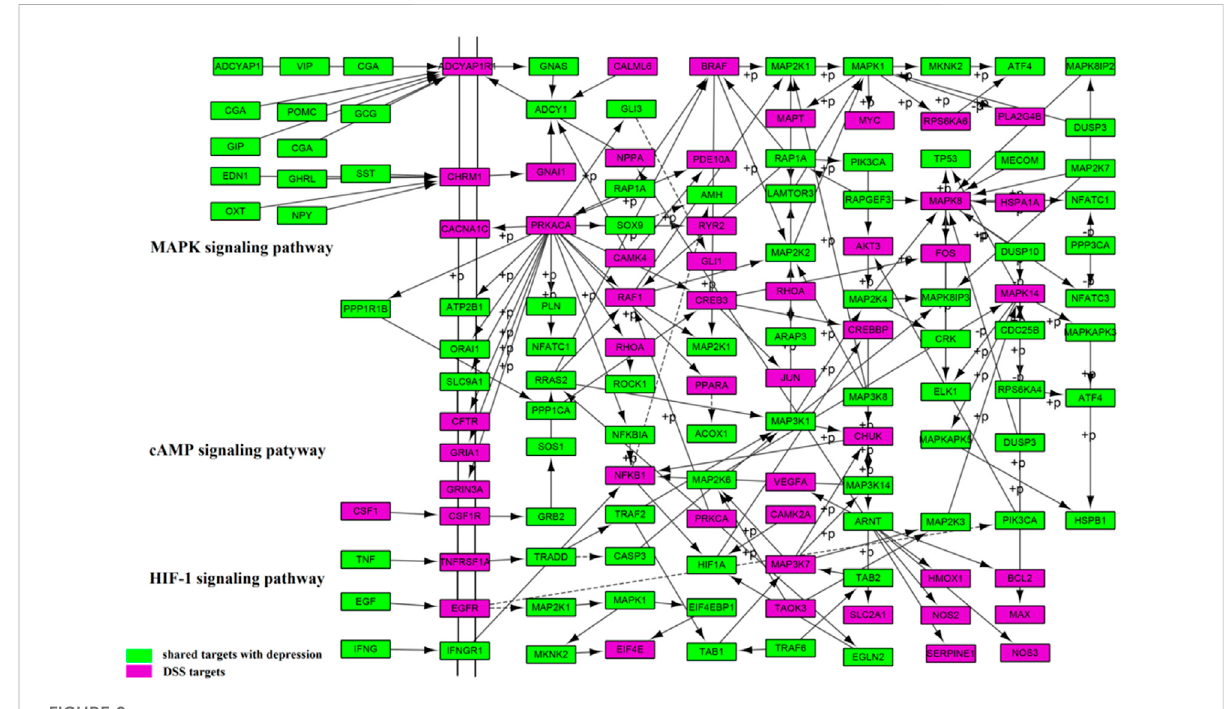
FIGURE 9 Distribution of targets of FCG in the comprehensive signaling pathway. FCG, functional components